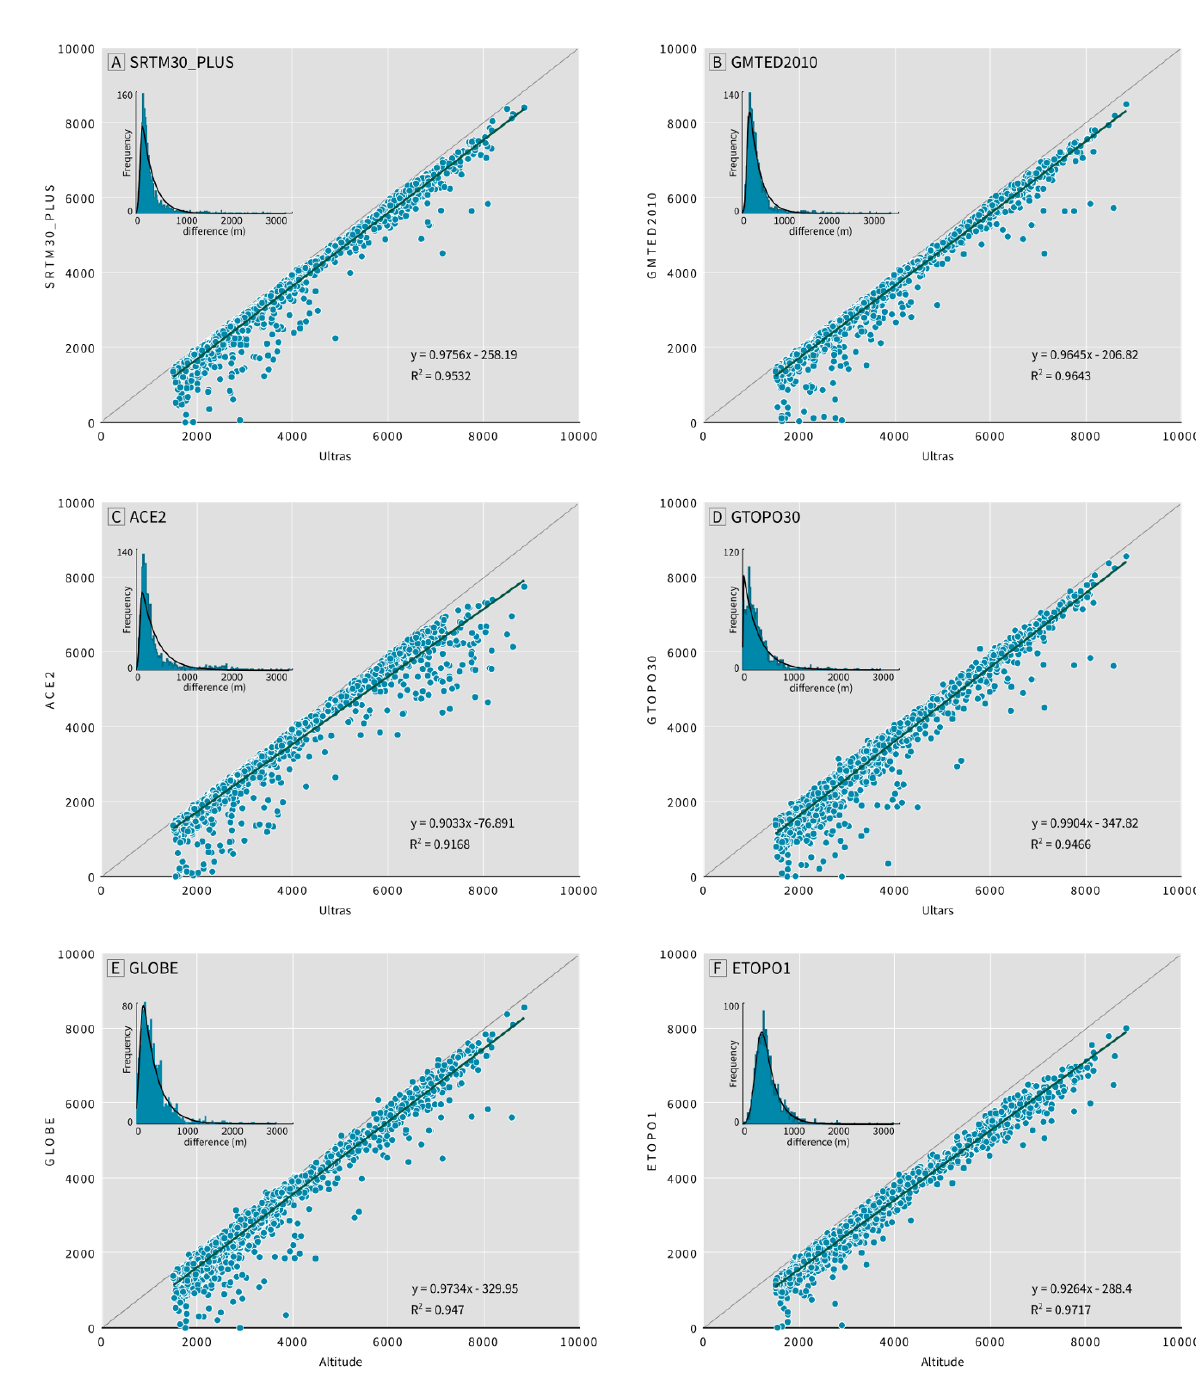
Figure 2: Histograms and scatter plots of differences between altitudes of ultra-prominent peaks and analysed GDEMs. A) SRTM30 PLUS; B) GMTED2010; C) ACE2; D) GTOPO30; E) GLOBE; F)